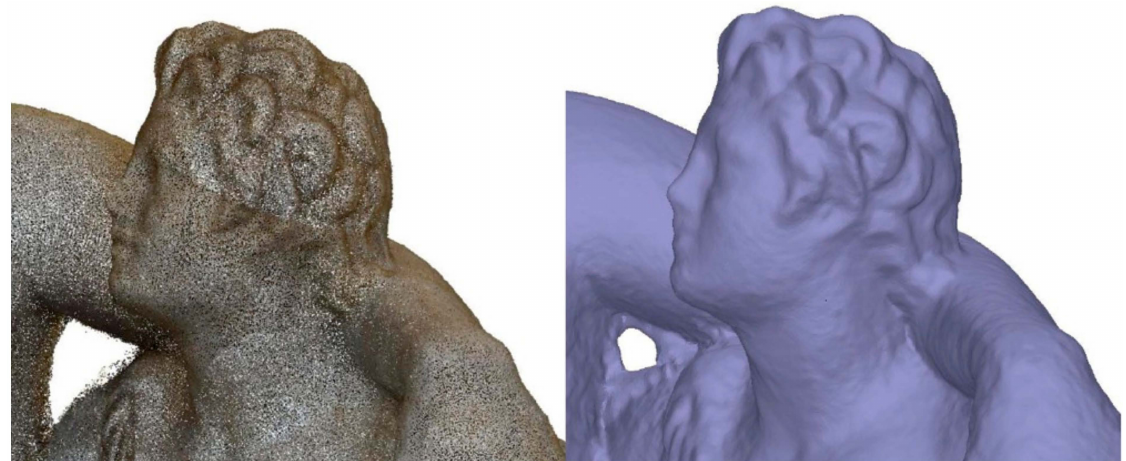
Figure 11. Detail of the point cloud ( left ) and of the mesh ( right ).